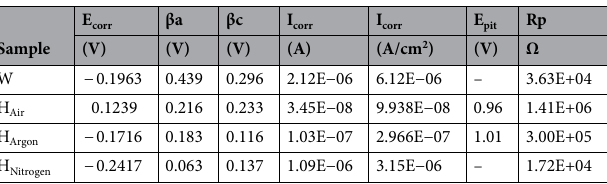
Table 6. Electrochemical parameters of weld zone after potentiodynamic polarization measurements.